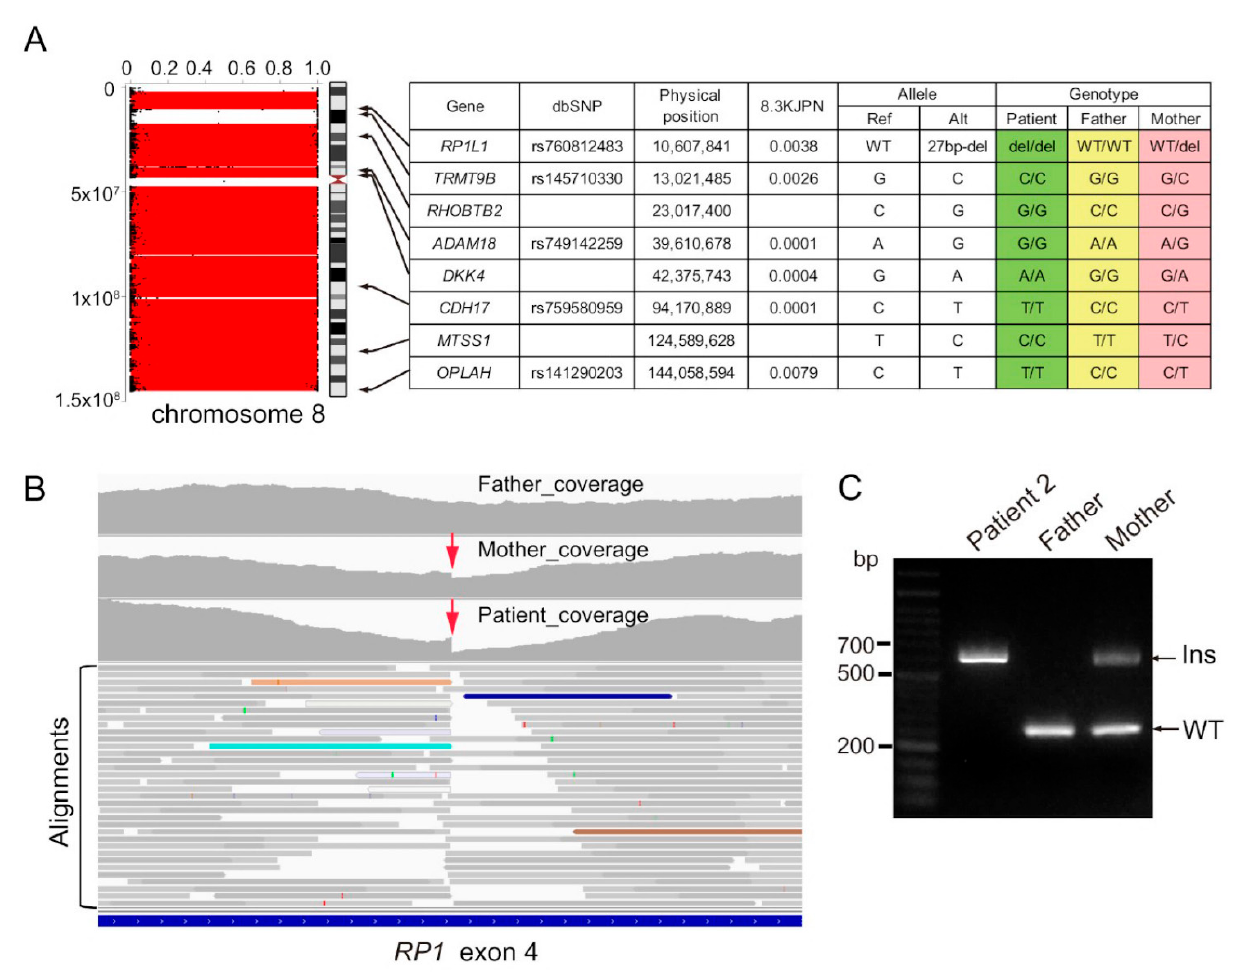
Figure 4. Genetic findings in patient 2. ( A ) (Left) H3M2 analysis using WES data showed LOH stretches on the whole of chromosome 8. (Right) Gene name, physical position, allele frequency in 8.3KJPN, and genotypes of trio samples of eight candidate variants are shown. Homozygous for reference allele, homozygous for alternate allele, and heterozygous genotypes are highlighted in yellow, green, and pink, respectively. Trio genotypes indicated maternal uniparental isodisomy. ( B ) Integrative genomics viewer showed a sharp decline in sequencing depth at exon 4 of RP1 (red arrows), suggesting the Alu insertion. Discordant reads are highlighted in colors. ( C ) PCR analysis confirmed homozygous Alu insertion in the patient, and his mother was a carrier of the insertion.